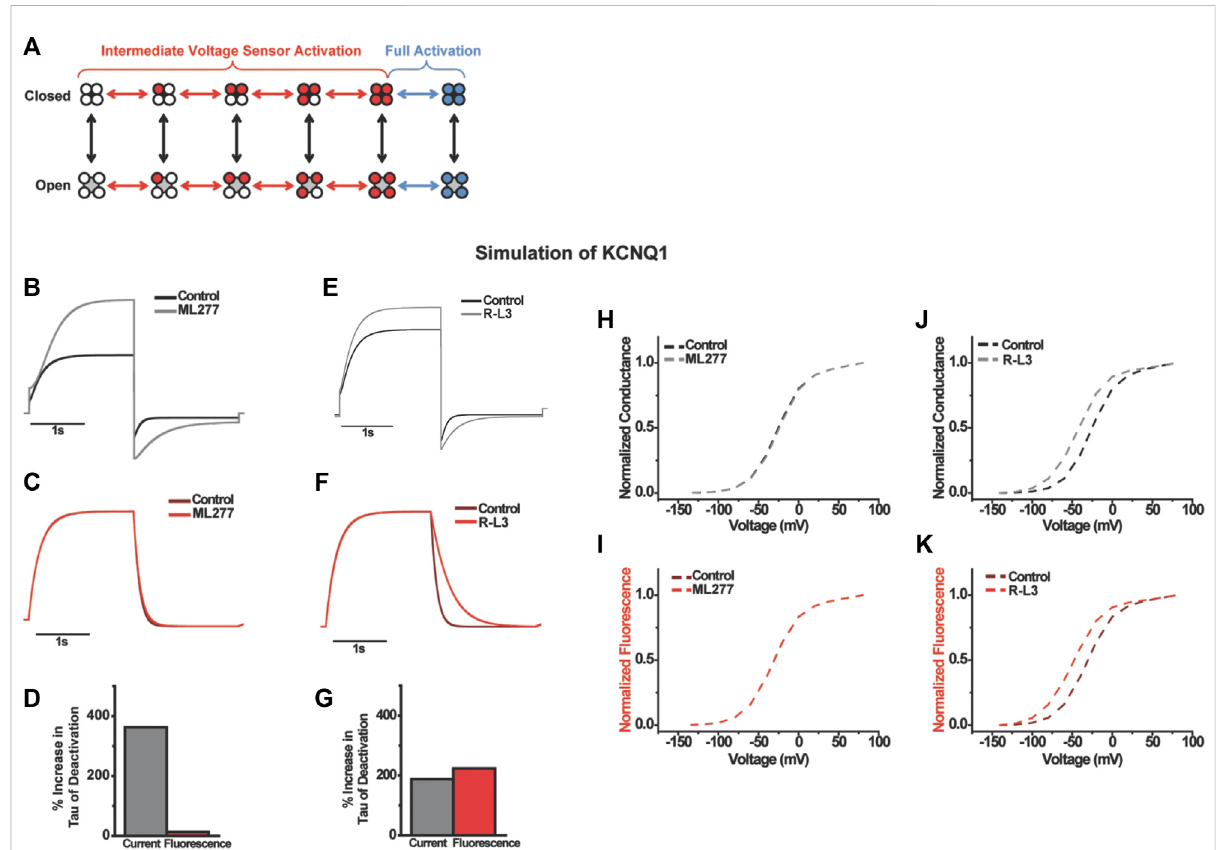
FIGURE 6 Computational modeling the effects of ML277 and RL-3 on KCNQ1. A 12-state model with intermediate and activated states was used (A) . ML277 was modeled as a pure modulator slowing pore opening with no effect on voltage sensing while RL-3 was modeled with only changes to deactivation of voltage sensing. Current, fl uorescence, and time to half inactivation agree with experiments (B – G) and the voltage-dependent properties (H – K)